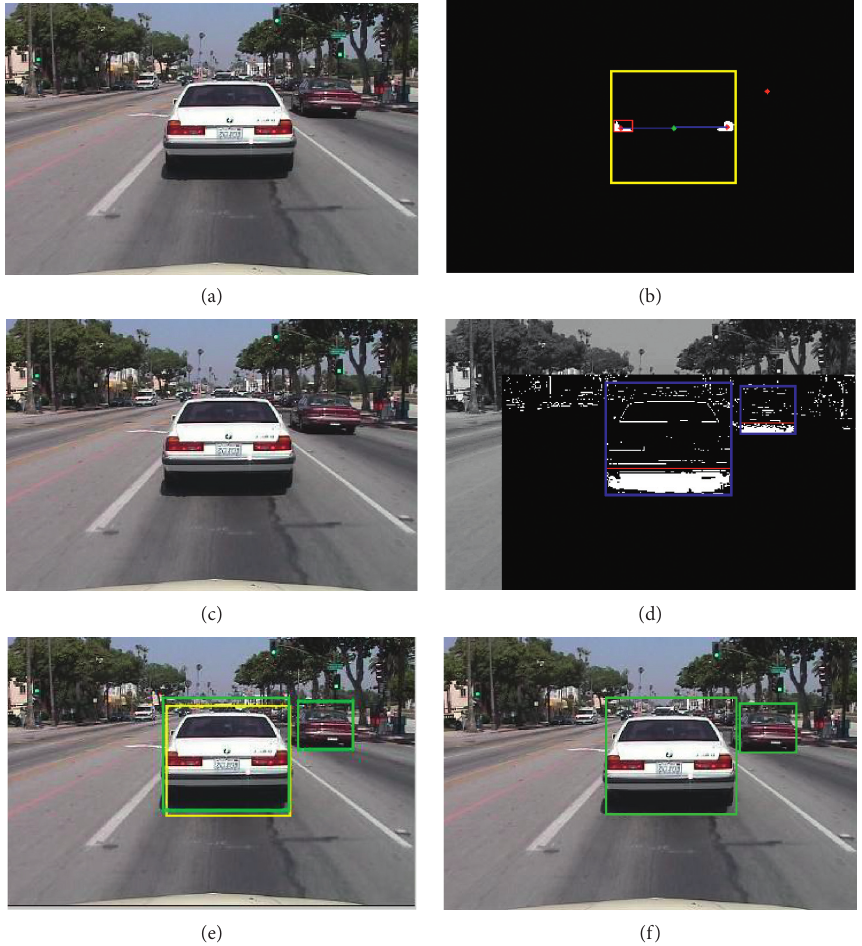
Figure 11: The detection results of interest region based on the composite feature of the taillight and shadow in sunny day environment. (a) The original image. (b) Taillight extraction results. (c) The original image. (d) Shadow extraction results. (e) Comparison results of vehicle detection based on single feature. (f) Vehicle detection results based on composite features.